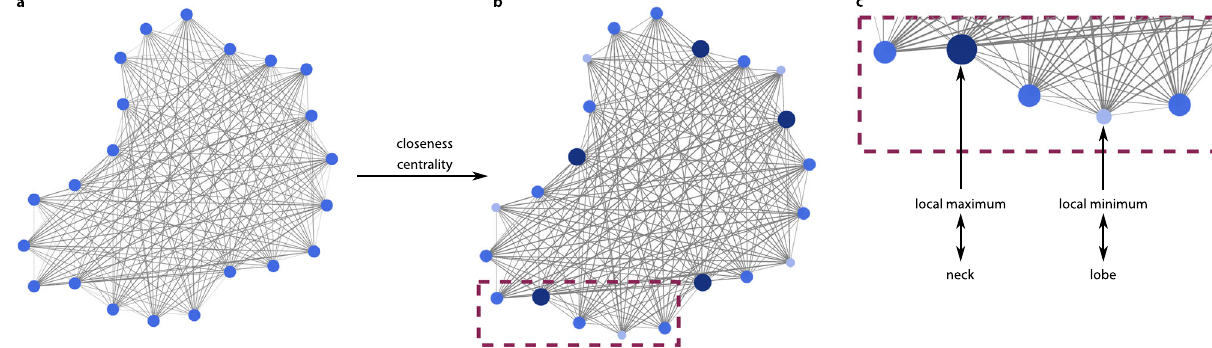
Fig. 5 Detection of lobes and necks in pavement cells based on visibility graphs. a , b The closeness centrality is calculated for the nodes of a visibility graph, visualized by different node sizes. c Lobes (light blue nodes) and necks (dark blue nodes) correspond to the local minima and maxima along the contour, respectively.